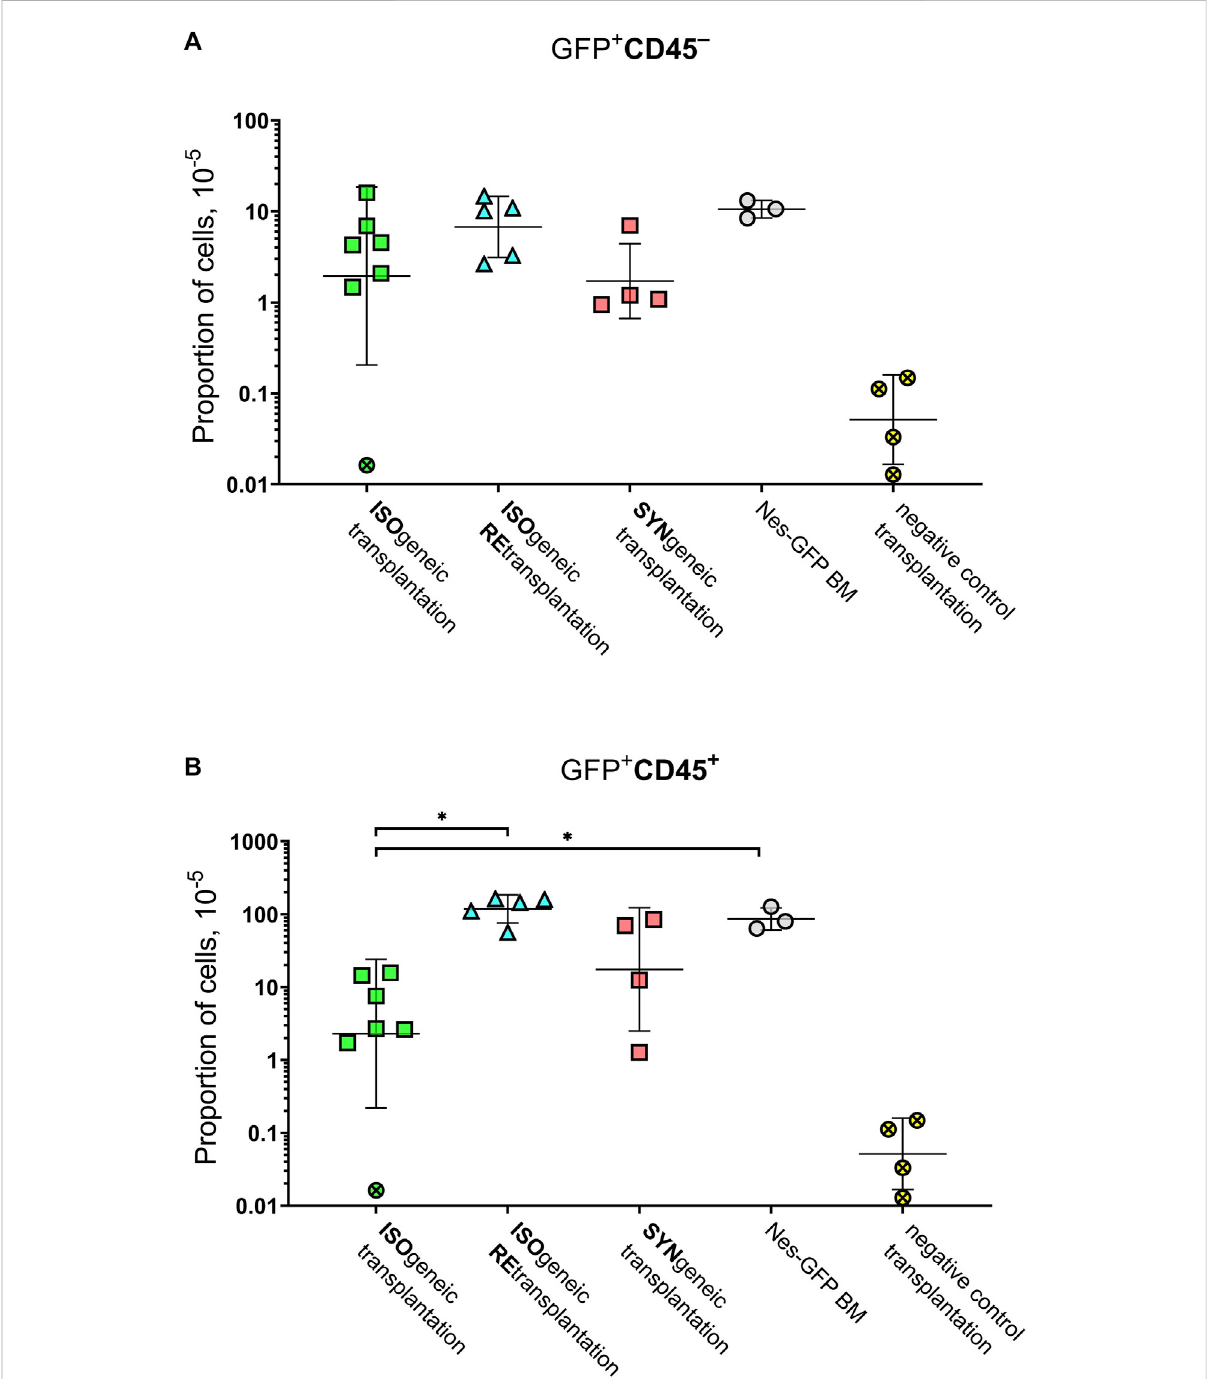
FIGURE 4 Graphical representation of the frequencies of GFP + cells. (A) GFP + CD45 – cells. (B) GFP + CD45 + cells. Horizontal lines designate geometric mean values. Whiskers designate geometric standard deviation. Crossed markers designate samples, in which GFP + cells were not detected. They were processed as described in Materials and Methods to estimate measurement